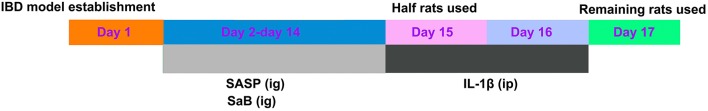
Experimental flowchart for the present study.